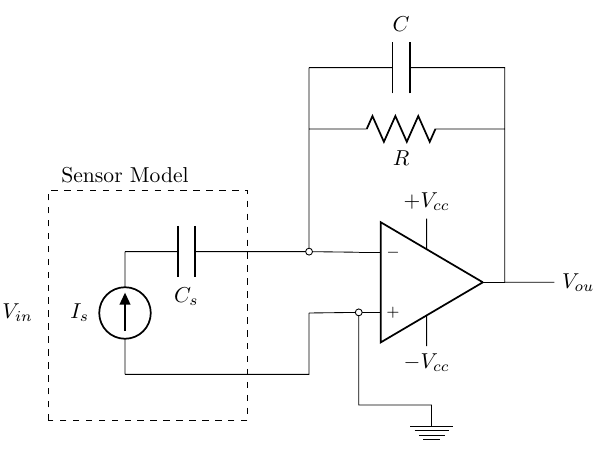
Figure 2. Charge amplifier